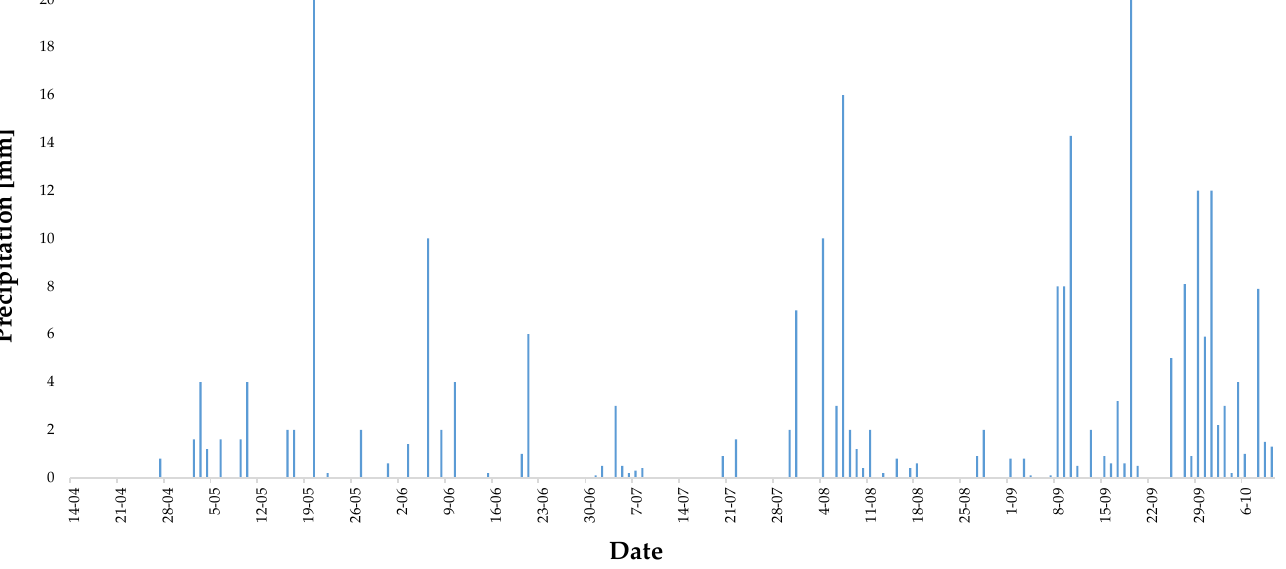
Figure 2. The sum of daily precipitation in the period from sowing to harvesting of maize.